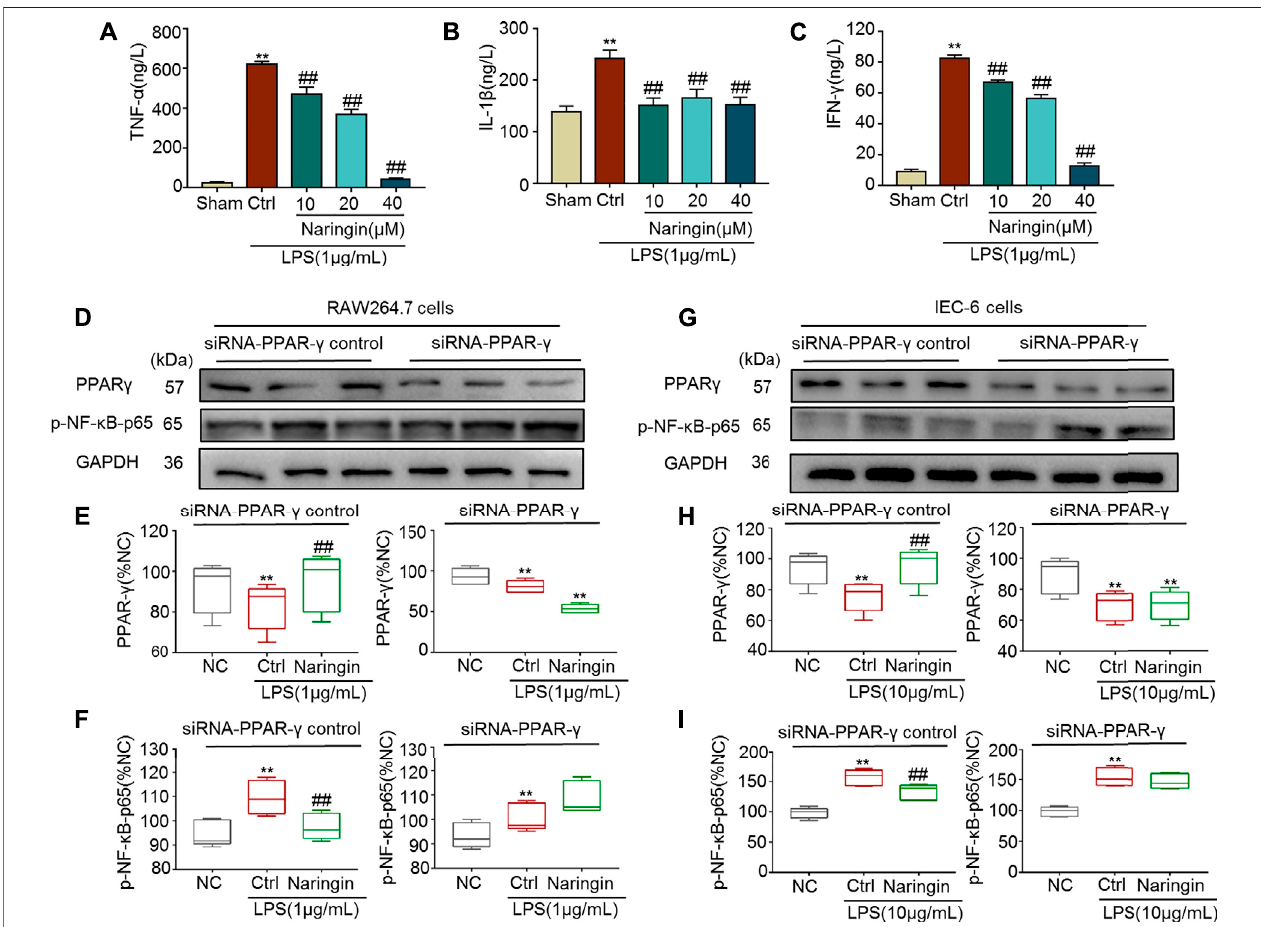
FIGURE9| Theanti-in fl ammatoryeffectofnaringin(20 μ M)waseliminatedbysiRNAtargetingPPAR- γ .Expressionlevelsofthecoloniccytokines (A) TNF- α , (B) IL- 1 β , (C) IFN- γ in DSS-induced RAW264.7 cells were determined by ELISA. Expression of PPAR- γ and p-NF- κ B-p65 in the absence and presence of siRNA targeting PPAR- γ in (D – F) RAW 264.7 and (G – I) IEC-6 cells. Dataare expressed as mean ± SD. Values in correspondingsham or normal control(NC) group areset to100%and other values are given relative to the control values. ** p < 0.01 compared with sham/NC group; ## p < 0.01 compared with DSS/LPS control group or as indicated; n (cid:2) 3 samples in western blotting experiments; n (cid:2) 6 samples for other experiments. These blots are cropped, and the full-length blots are presented is in the Supplementary Figures S16 – S21 .